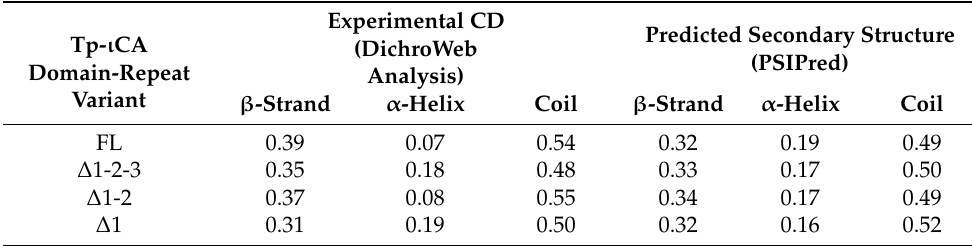
Table 2. Proportion of secondary structural elements in tp ι -CA, derived either from the experimental CD data or from